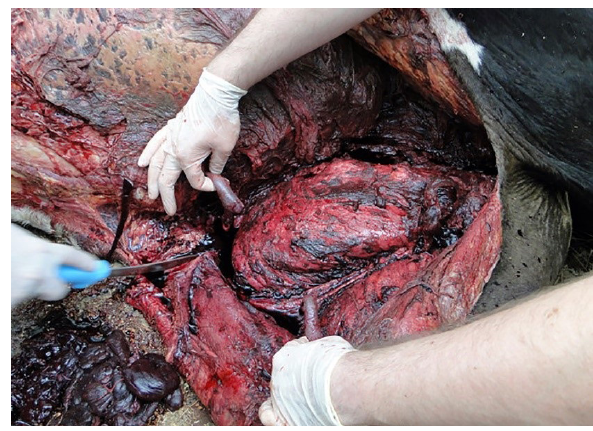
Figure 4. Clots in the mammary gland and rupture of the mammary